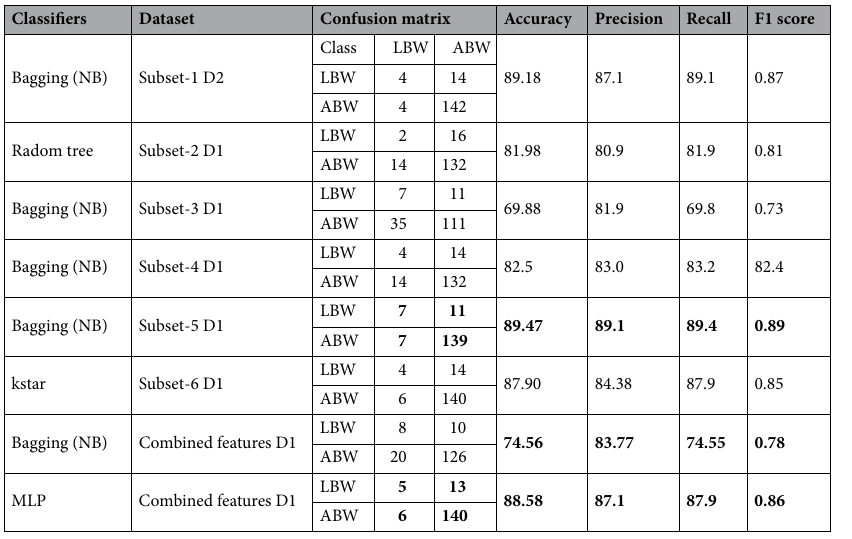
Table 4. Summary of the best result across all subsets. Significant values are in